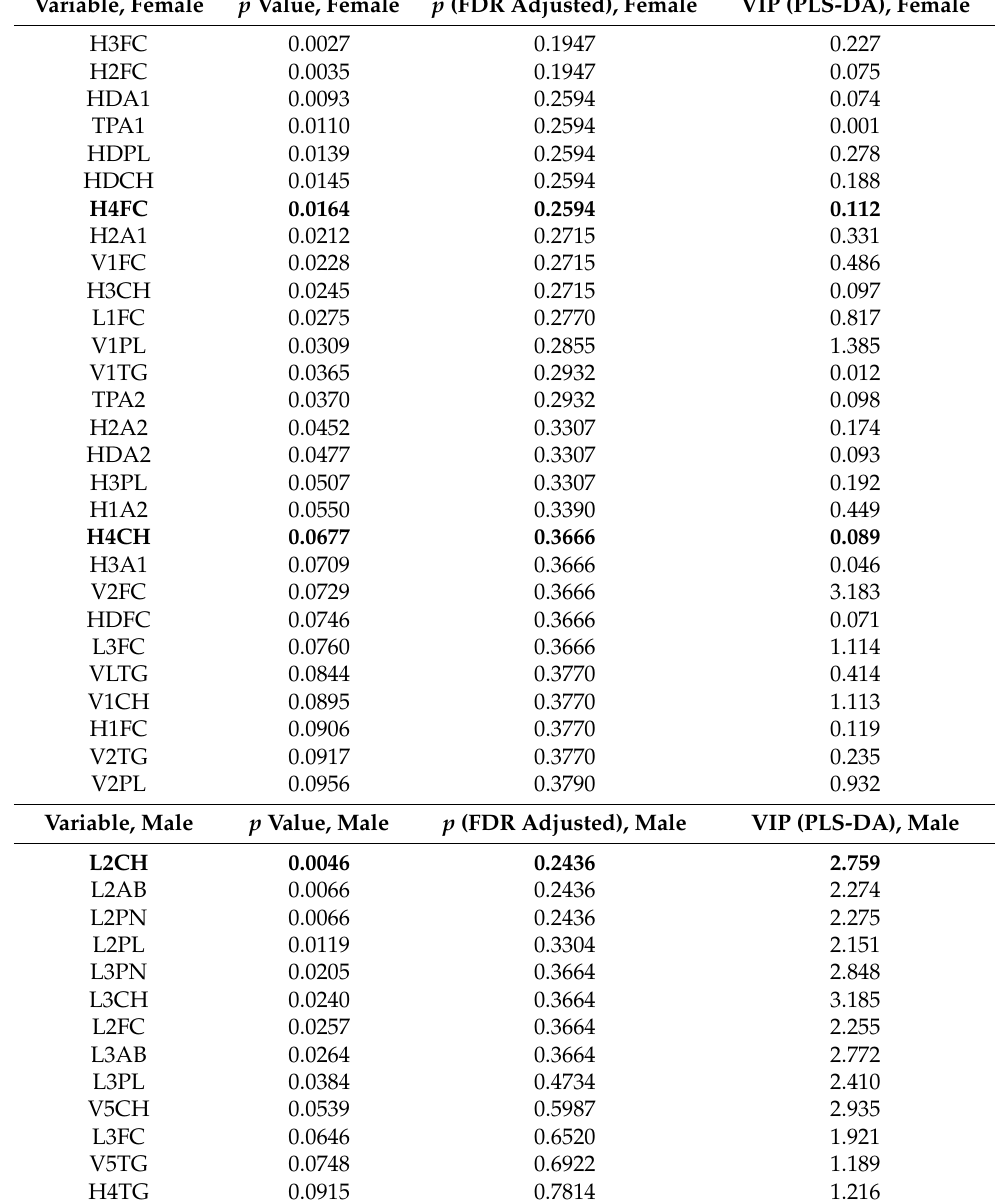
Table A2. ANOVA series ( p ANOVA < 0.01) highlights variables based on the male-female analysis within three-group comparisons (AD, Con, and MCI) for the dataset from the whole cohort lipoprotein data. Data entries from the Supplementary Materials Table S3 are highlighted in